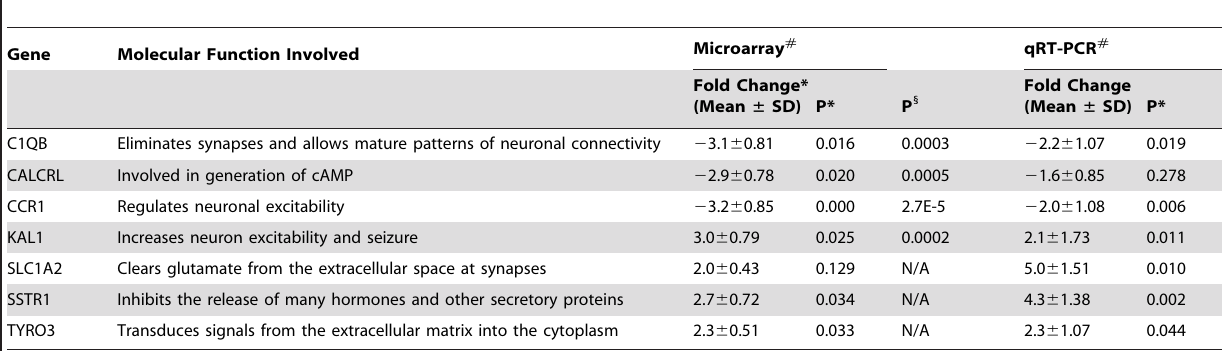
Table 3. Microarray identified differentially expressed genes validated by real-time qRT-PCR.